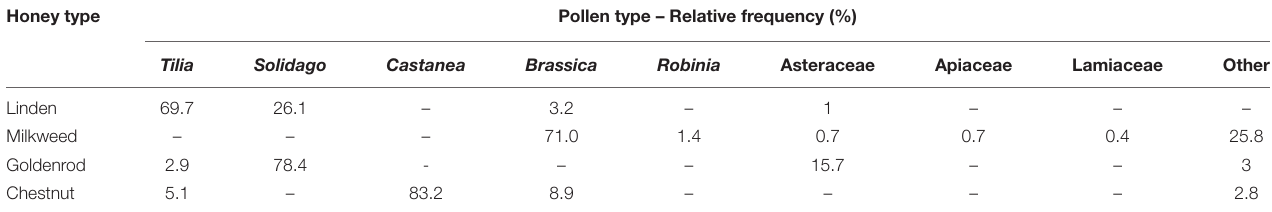
TABLE 2 | Pollen spectrum of the studied